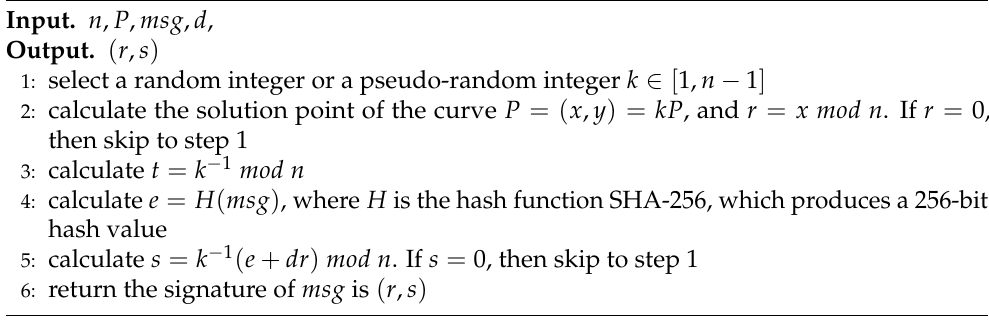
Algorithm 5 ECDSA_Sign_SK X { msg }